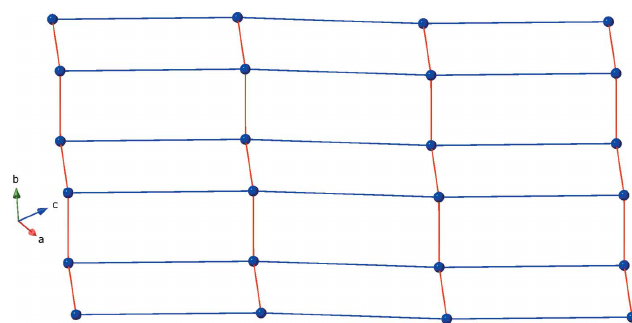
Figure 5 Schematic perspective of the (4,4) rectangular grid topology in the title compound. The spheres represent the copper atoms, the red lines represent the dip ligands, and the blue lines represent the bpu